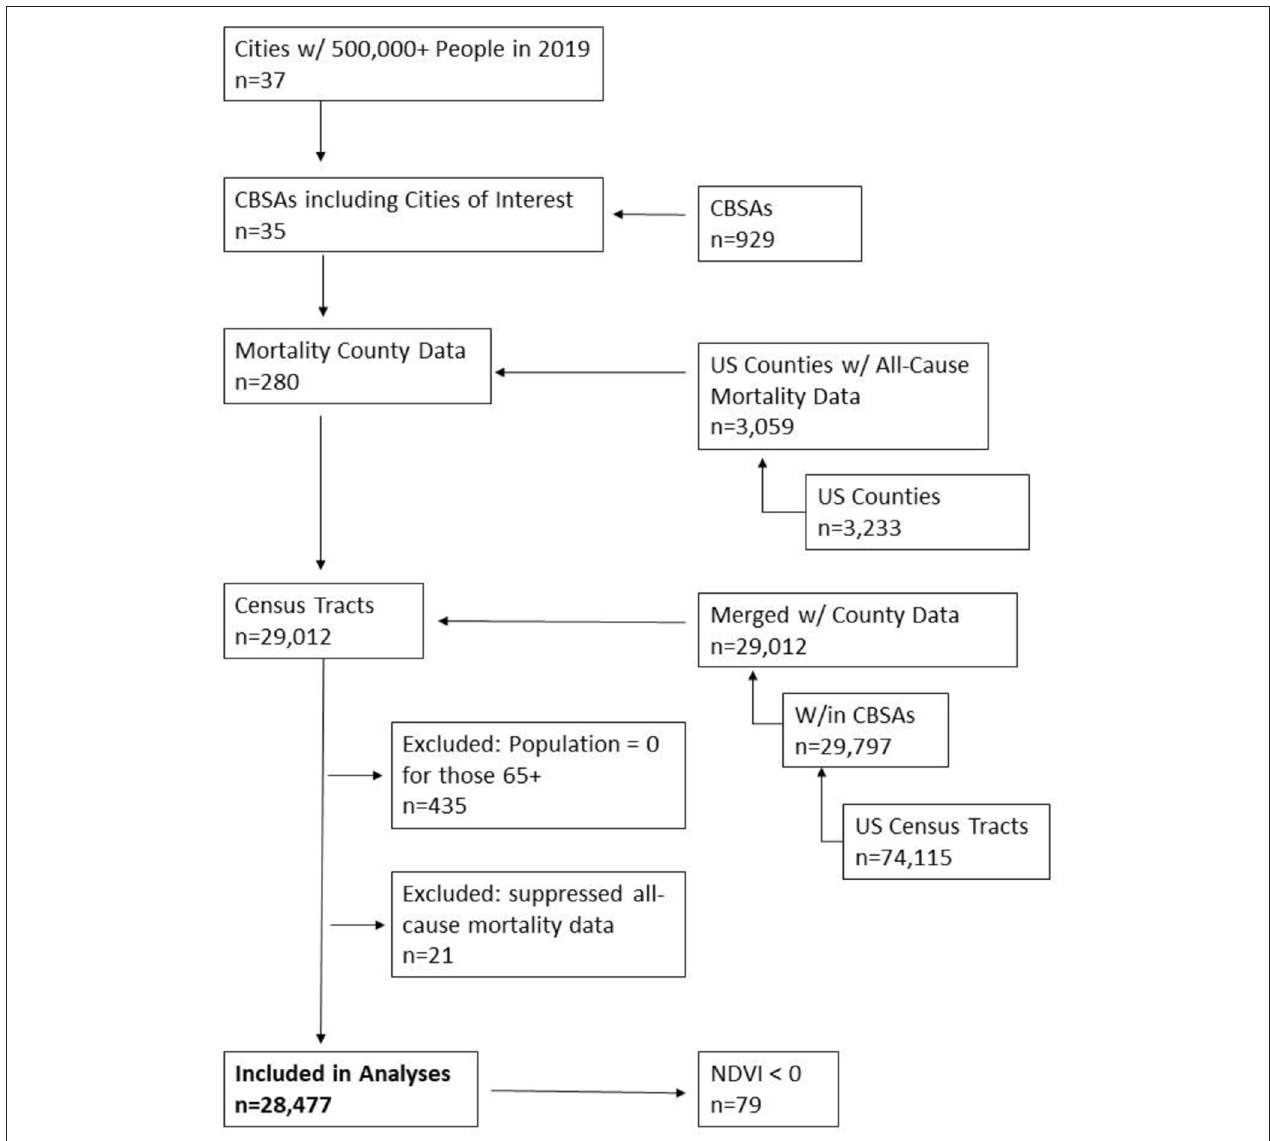
FIGURE 1 | Flow chart of